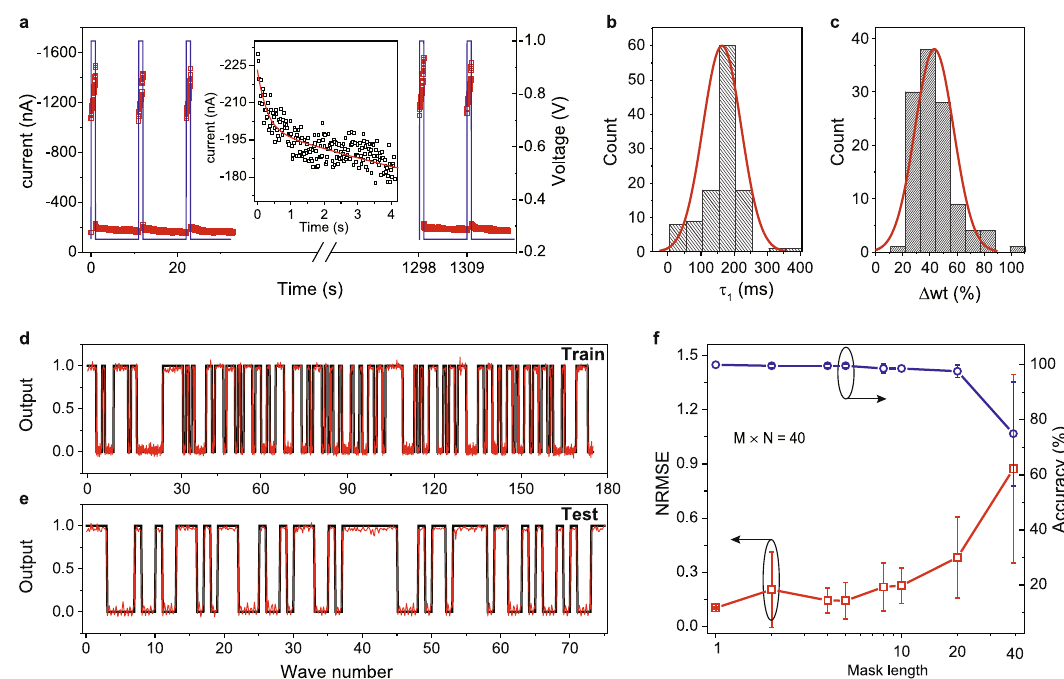
Fig. 5 | Signal processing based on the molecular synapse. a The current response ( red markers) by placing 120 periodic pulses ( blue line). The amplitude and width of the write (potentiation) pulse are − 1.0V and 1s while the amplitude and width of the read (depression) pulse are − 0.25V and 10s. The inset shows the magni fi ed current decay of the last read pulse, which is fi tted by using a double exponential function. b , c Statistical results of time constant τ 1 (read pulse) and synapticweightchange Δ wt(writepulse)in(a).Thesolidred linesare fi ttingtothe